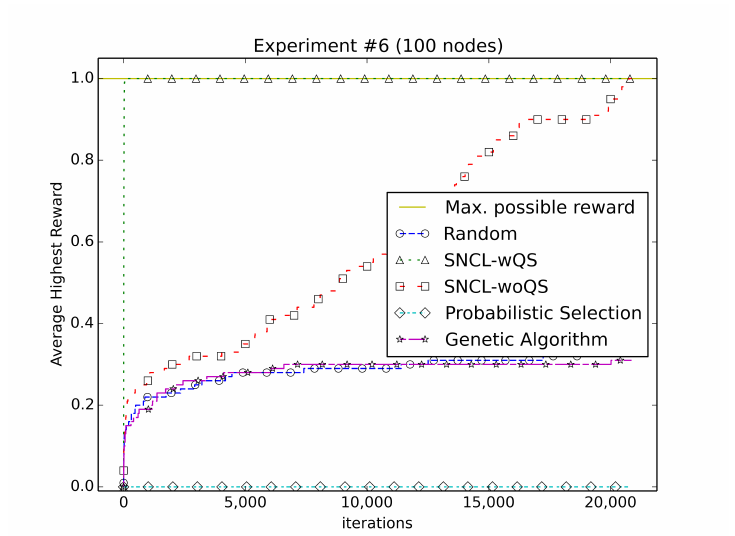
Figure 8. Using reward Equation (6).